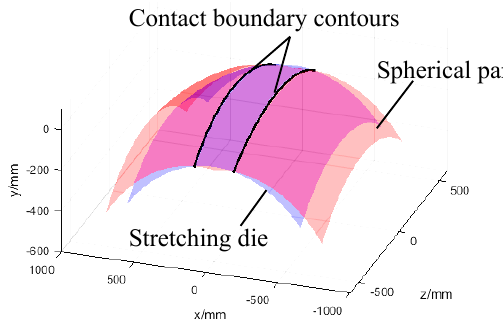
Figure 16. Contact state between the deformed sheet metal and the die.